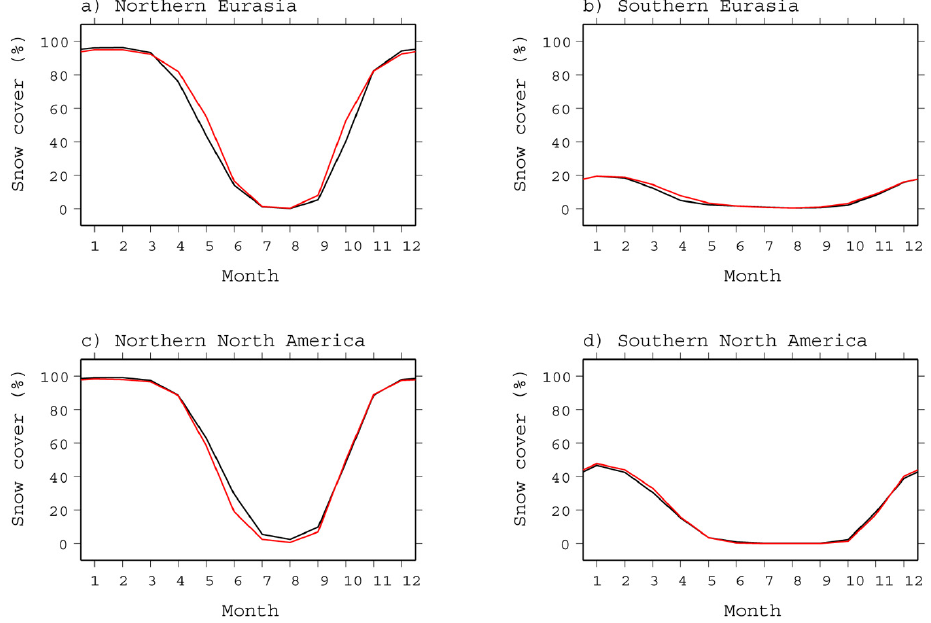
Fig. 2. Seasonal cycles of observed (black) and simulated (red) multi-model mean snow cover for southern (latitude < 50 ◦ N) and northern (latitude ≥ 50 ◦ N) Eurasia and North America, average over the 1979–2005 period.